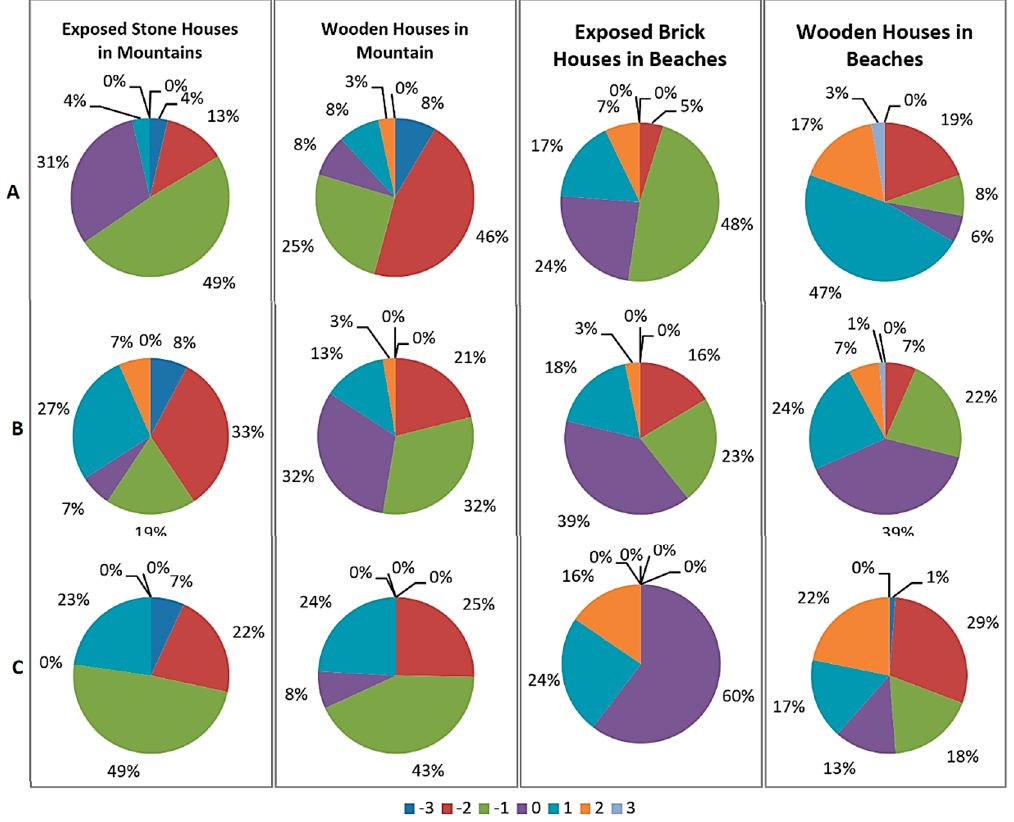
Figure 10. The percentage of thermal sensation of each type of house at the beginning of the wet season ( A ), in the middle of the wet season ( B ), and at the start of the dry season ( C ).